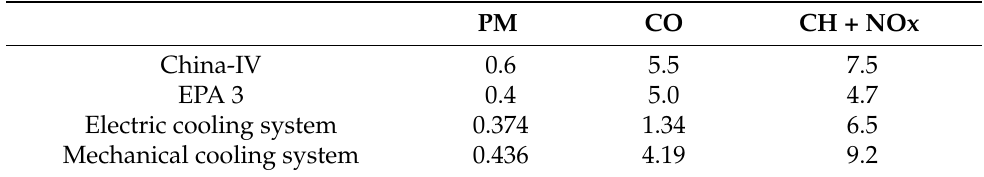
Table 1. The test results of exhaust pollutants and limits of emission standards [21,23], with a unit of g/(kW ·